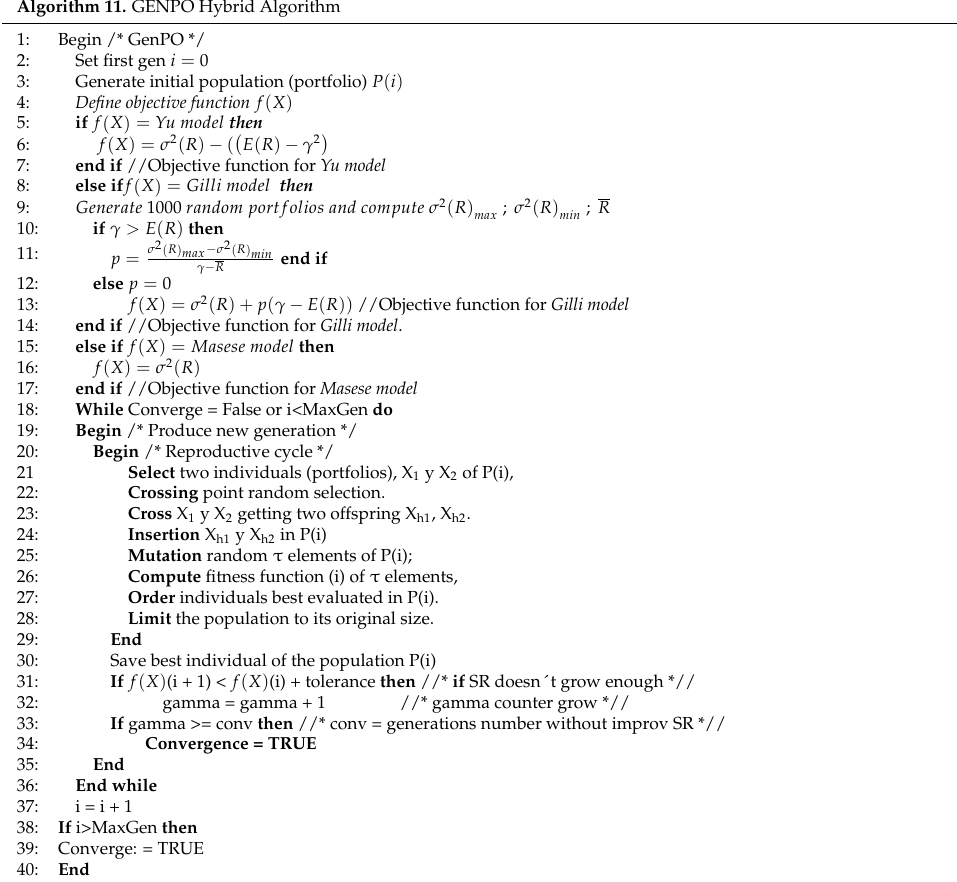
Algorithm 11. GENPO Hybrid